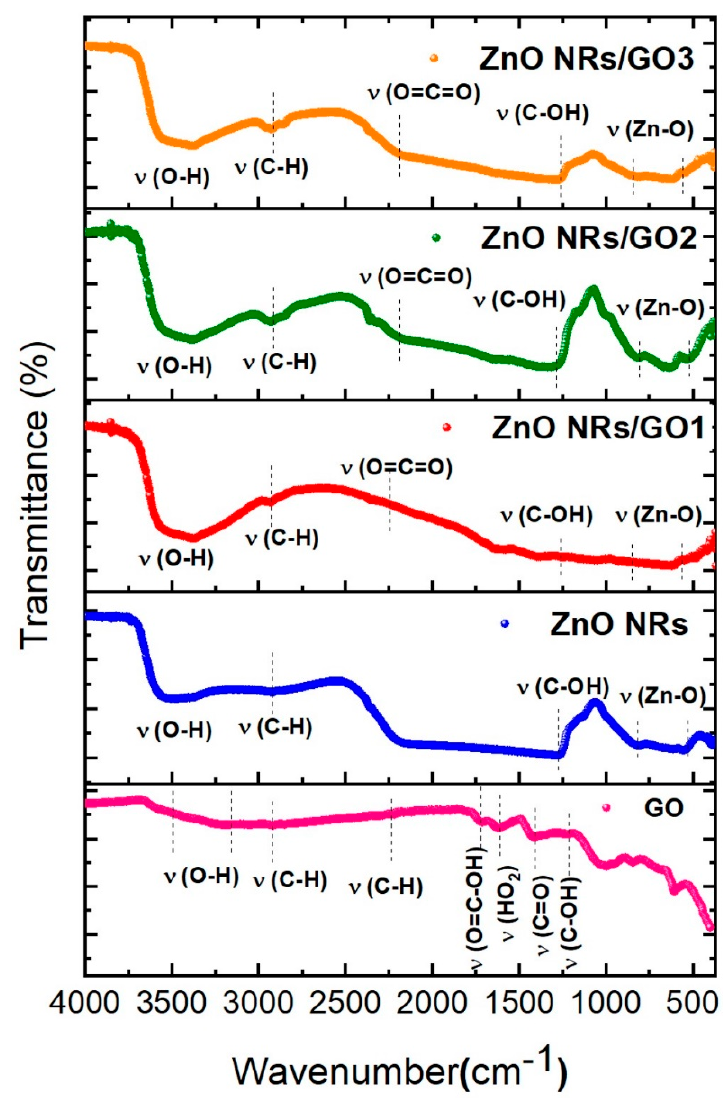
Figure 6. Fourier transform infrared (FTIR) spectra of GO, ZnO NRs, and ZnO NRs / GO nanocomposites with different GO concentrations.